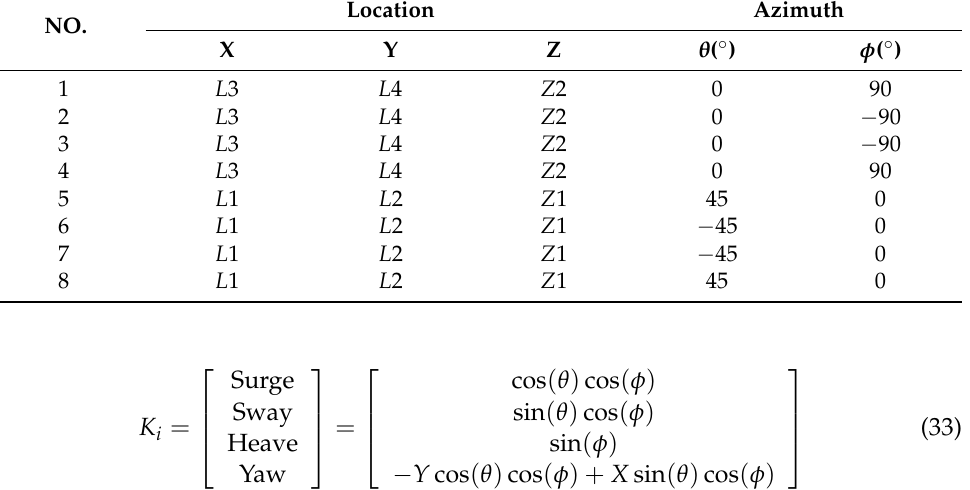
Table 1. Location and azimuth of the thrusters. NO.